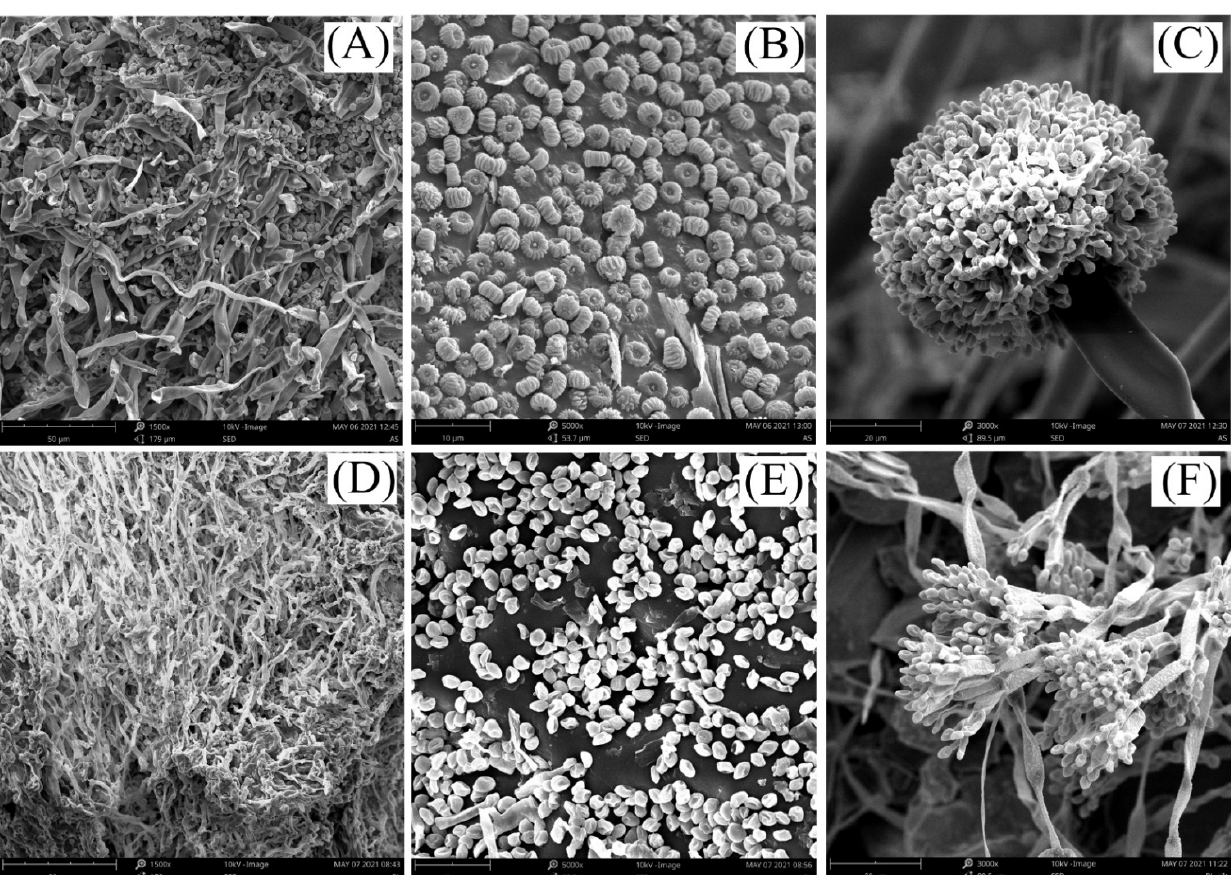
Figure 7. Scanning electron microscope (SEM) photographs showing structures of fungal strains growing on carriers: ( A )— Aspergillus niger G119AA, mycelium with hyphae; ( B )— A. niger G119AA, conidia; ( C )— A. niger G119AA, conidiophore with conidial head; ( D )— Paecilomyces lilacinus WT15A, mycelium with hyphae; ( E )— P. lilacinus WT15A, conidia; ( F )— P. lilacinus WT15A, conidiophores with phialides and conidia.